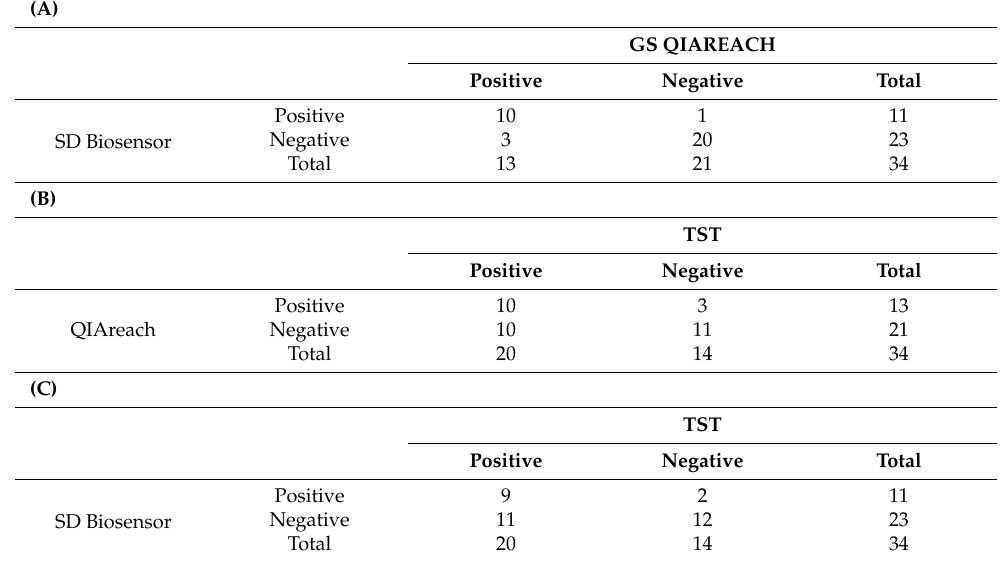
Sensitivity (new technique) 76.92%; Specificity (new technique) 95.24%. Sensitivity (new technique) 50.00%; Specificity (new technique) 78.57%. Sensitivity (new technique) 45.00%; Specificity (new technique)